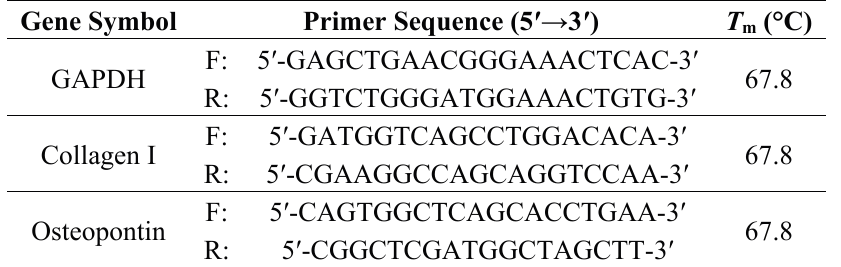
Table 1. Sequences of primers used in real-time polymerase chain